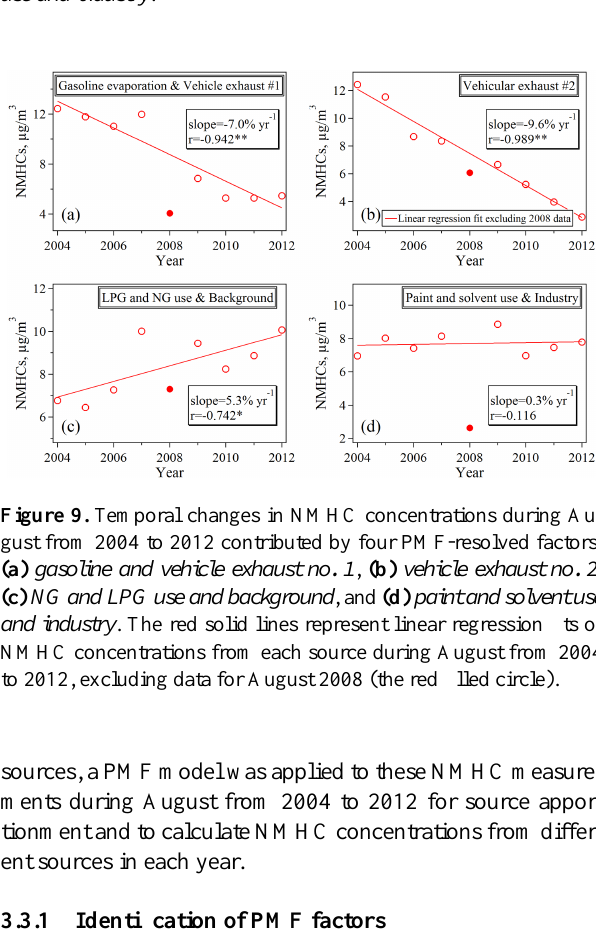
Figure 8. Profiles of four PMF-resolved factors (gray bars) and distributions of each species among these factors (black diamonds): (a) gasoline evaporation and vehicle exhaust no. 1 , (b) vehicle exhaust no. 2 , (c) LPG and NG use and background , and (d) paint and solvent use and industry .